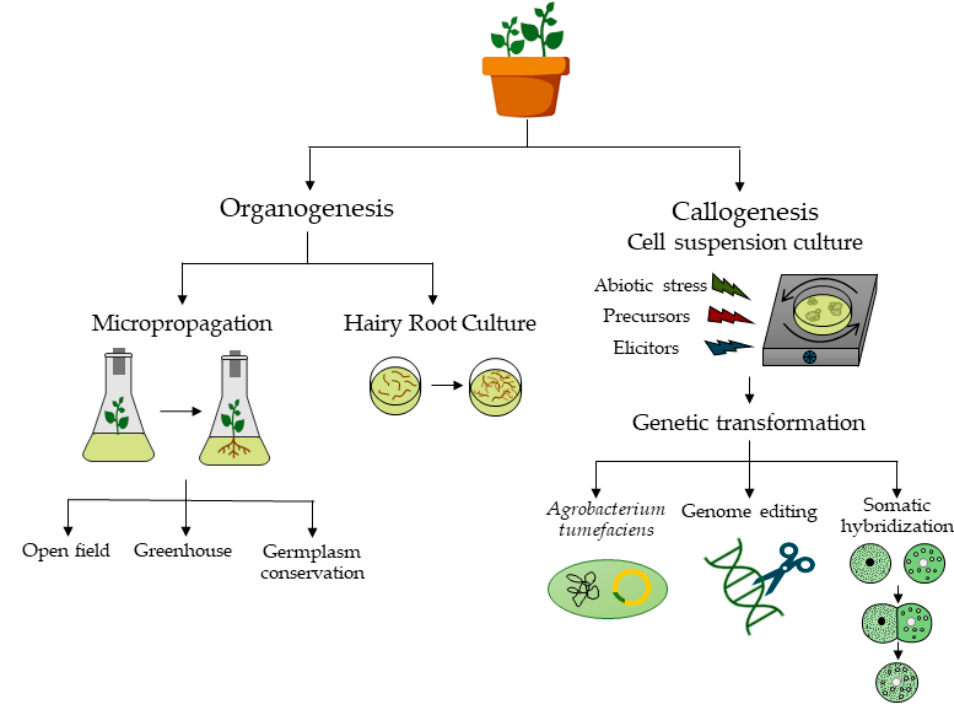
Figure 1. Diagram of methods and applications of in vitro tissue culture applied to halophyte plants.